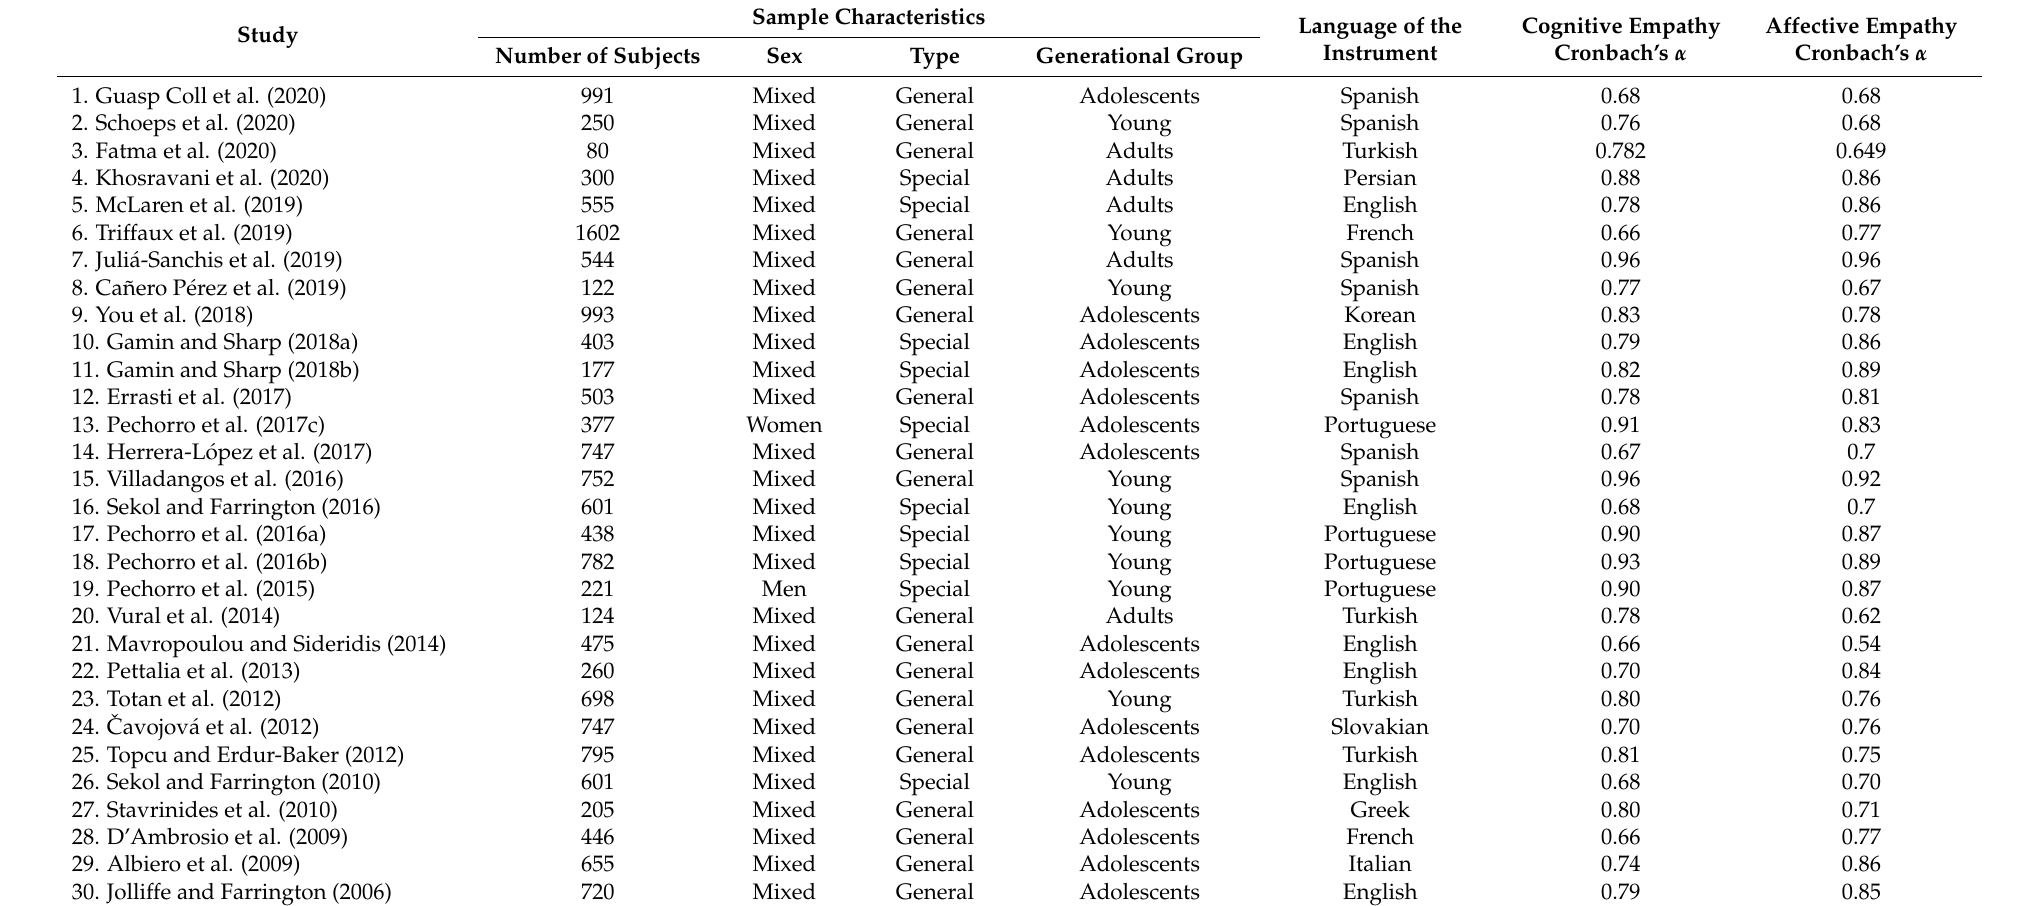
Table A3. Characteristics of the studies introduced in the